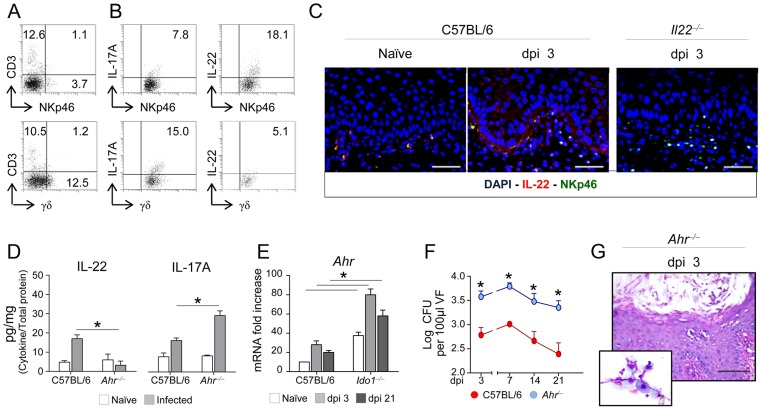
IL-22 is produced by innate lymphoid cells via AhR.(A) Numbers of CD3+ NKp46+ and CD3+ γδ T cells in total vaginal cells from naïve C57BL/6. Numbers refer to % positive cells (one representative experiment out of 2). (B) IL-22-and IL-17A-producing NKp46+ and γδ T vaginal cells. Cells were purified from the vagina of naïve C57BL/6 mice and intracellularly stained for IL-17A or IL-22 before FACS analysis. Numbers refer to % positive cells. (C) Vaginal immunohistochemistry of naïve (dpi 0) C57BL/6 or IL-22-deficient mice at 3 days post-infection (dpi). Staining was done with anti- NKp46-PE and anti-IL-22-FITC antibody. Cell nuclei were stained with DAPI (blue). Representative pictures (out of 2 experiments) were taken with a 20× objective. Scale bars, 50 µm. (D) IL-22 and IL-17A levels on vaginal fluids (pg/mg, cytokine/total proteins for each sample at 3 dpi) of mice (n = 6) intravaginally inoculated with 5×106
C. albicans blastoconidia. *P<0.05 AhR-deficient vs. C57BL/6 mice. (E) AhR expression (RT-PCR) in the vagina of infected mice at different dpi. *P<0.05 IDO1-deficient vs. C57BL/6 mice. (F) Vaginal fungal burden and (G) vaginal histology of AhR-deficient mice (n = 6) intravaginally inoculated with 5×106
C. albicans blastospores. CFU (Log10 CFU/100 µl vaginal fluids ± s.e.m.) and vaginal histology (periodic acid-Schiff-staining at 3 dpi) were done at 3 dpi. In the inset, inflammatory cell recruitment in vaginal fluids by May–Grünwald Giemsa staining at 3 dpi. Representative images were acquired with a 40× and 100× objective respectively. Scale bars, 100 µm. Data are pooled or representative (histology) from 2 independent experiments. *P<0.05 AhR-deficient vs. C57BL/6 mice.